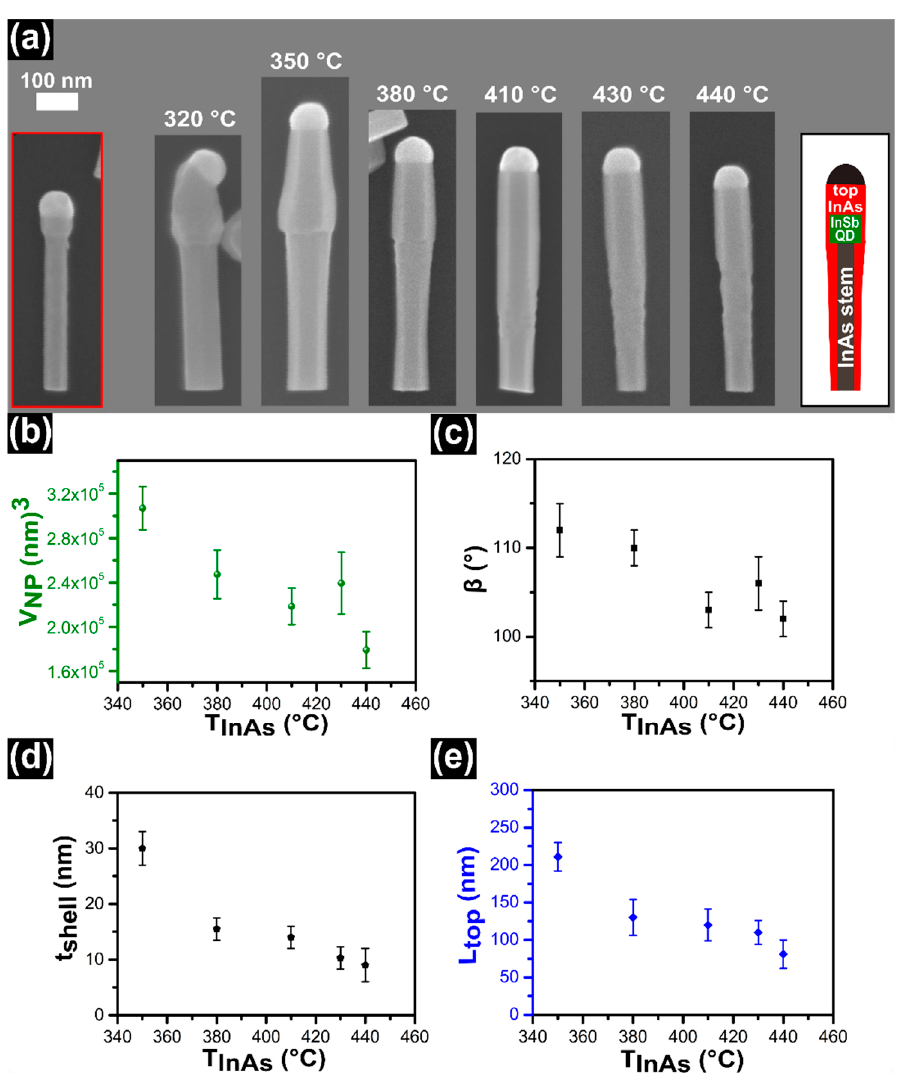
Figure 1. ( a ) Series of scanning electron microscope (SEM) images of the InSb/InAs quantum dot (QD) nanowires (NWs). The first NW shown in the red frame represents the InAs/InSb NW grown at 410 ± 5 ◦ C. The other panels represent the InSb/InAs QD NWs where the InAs top segment has been grown with the line pressures F In = 0.30 Torr and F As = 0.25 Torr and growth time 15 min at different growth temperatures ( T InAs ) as indicated in each panel. The drawing in the right side of the panel shows a schematic picture of the InSb/InAs QD NW structure. ( b ) Evolution of the NP volume as a function of T InAs . ( c ) Evolution of contact angle ( β ) of the In NPs on the top of NWs as a function of T InAs . ( d ) Evolution of the InAs shell thickness as a function of T InAs which represents the InAs radial growth around the InSb QD. ( e ) Evolution of length of InAs top segments ( L top ) as a function of T InAs . The symbols represent an average value of each sample obtained by measuring ~25 NWs and error bars represent the standard deviation of the